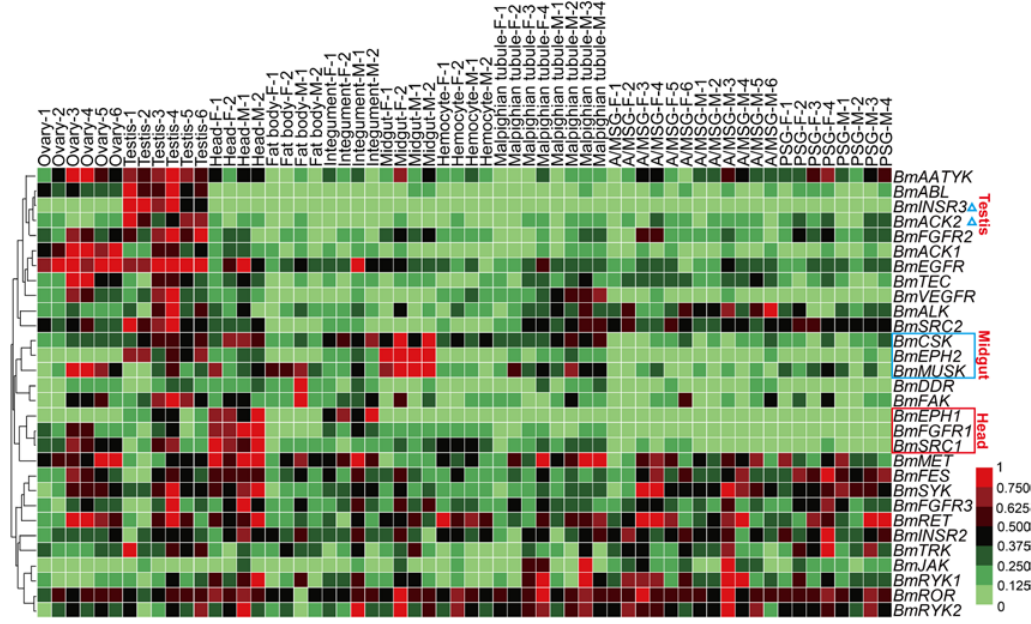
Figure 4. Microarray-based gene expression profiling of BmTK genes in multiple tissues. Biological repeats of each tissue are indicated with different numerals. F: female, M: male, A/MSG: anterior/median silk gland, PSG: posterior silk gland. Blue triangles indicate the genes with testis-specific expression. Red box indicates the genes with higher expression in the head. Blue box indicates the genes with high expression in the mid-gut.